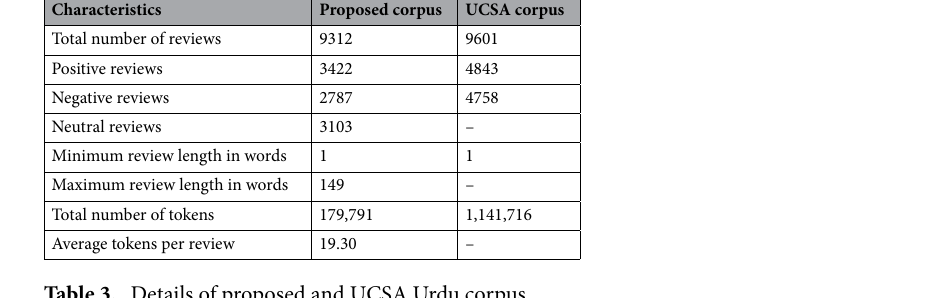
Table 3. Details of proposed and UCSA Urdu